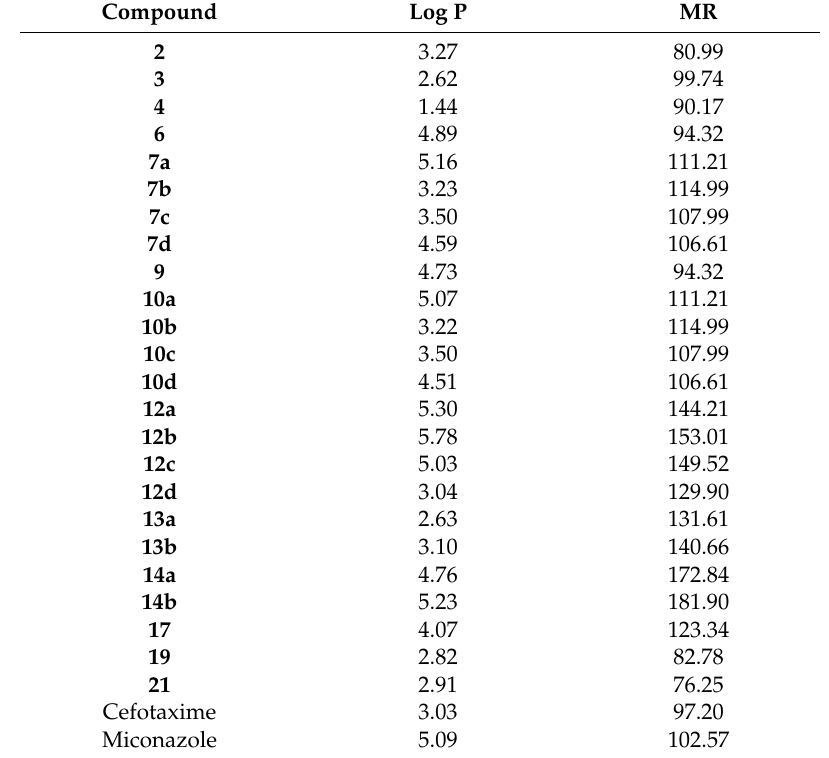
Table 1. Calculated log P and molar refractivity (MR) of newly synthesized compounds.